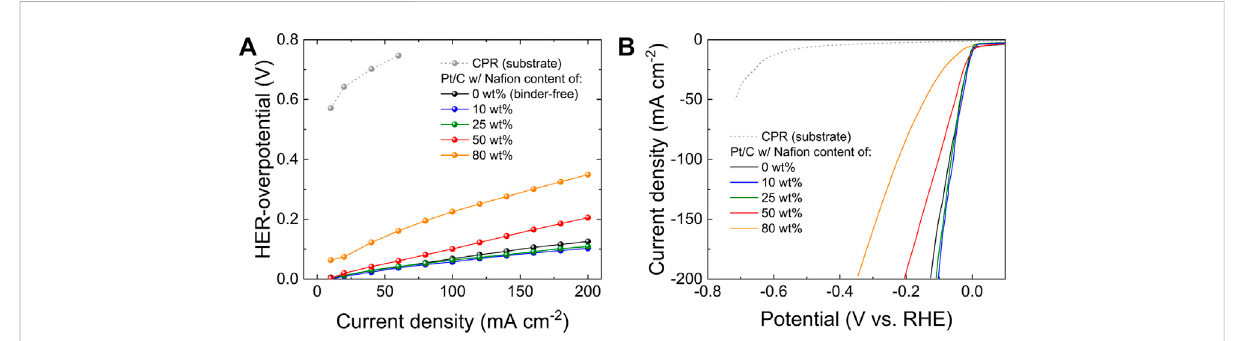
FIGURE 1 (A) Cathodic galvanostatic polarization curves and (B) potentiodynamic (polarization) LSV curves measured for the Pt/C electrodes produced with different Na fi on contents in the catalyst coating, i.e ., 0 wt% (binder-free electrode), 10 wt%, 25 wt%, 50 wt% and 80 wt%. The curves obtained for CPRs (electrode substrates) are also